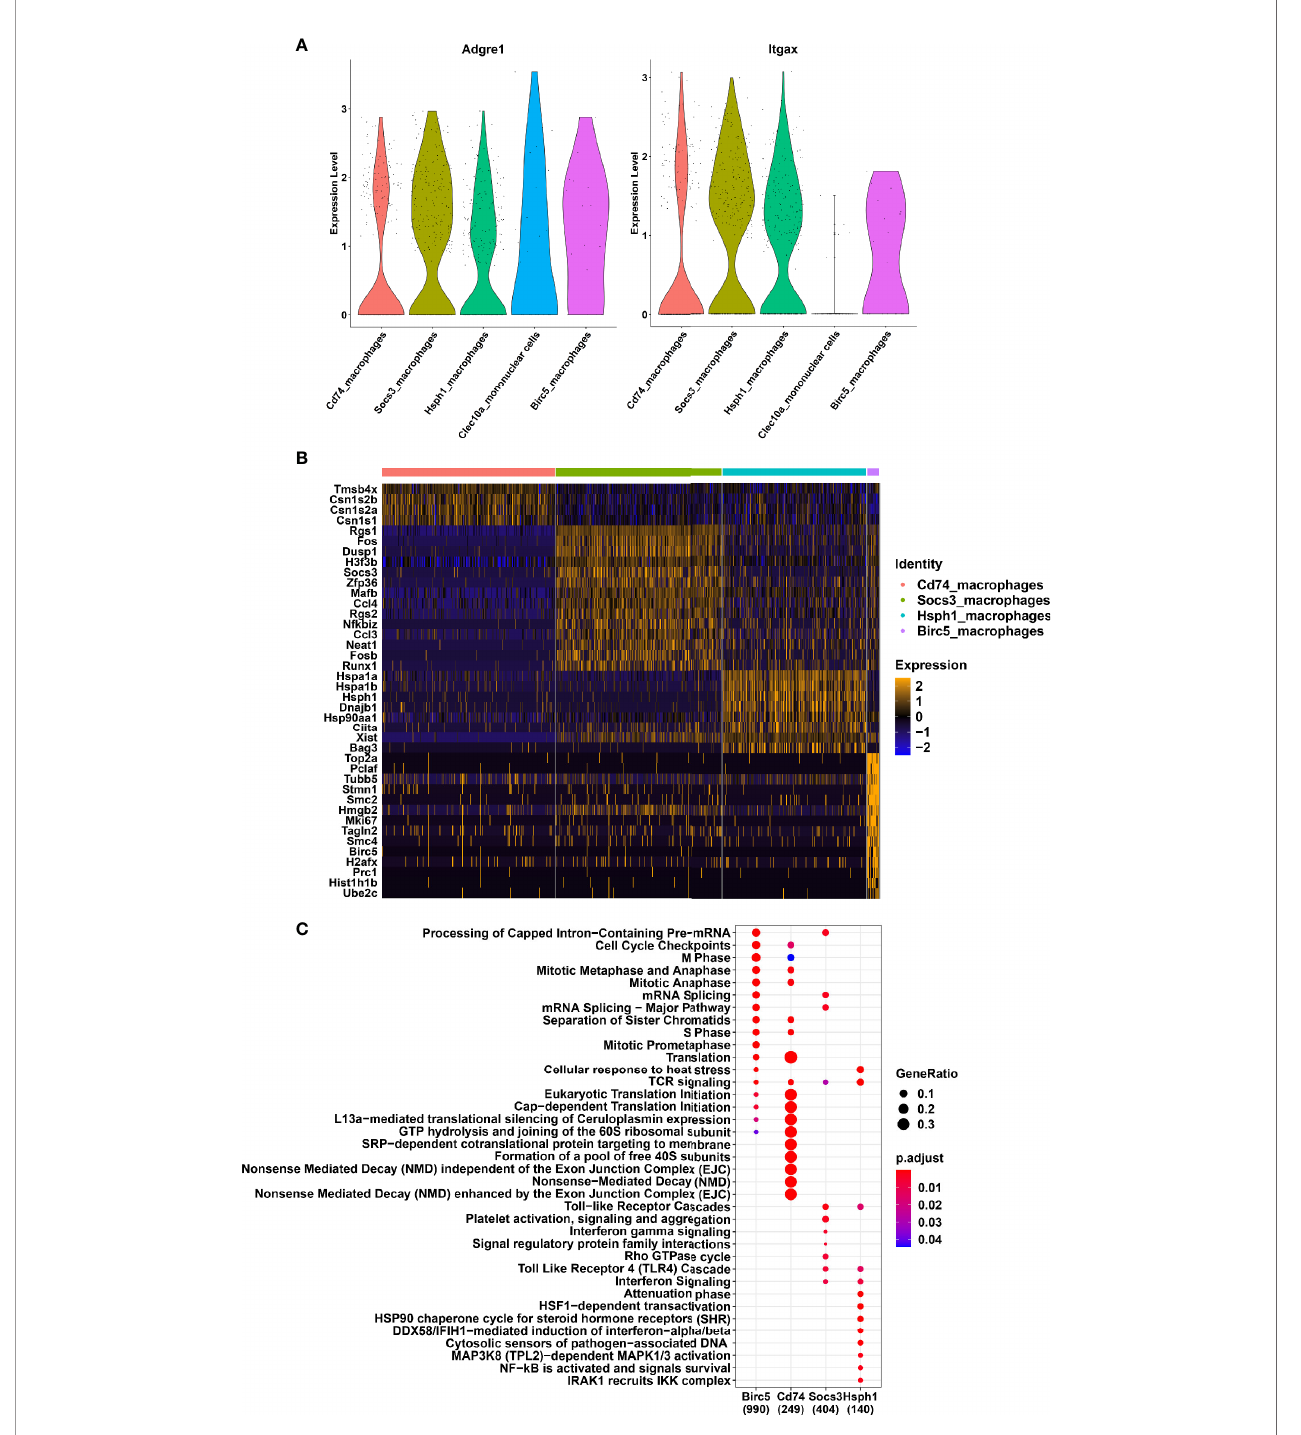
FIGURE 2 | Different subsets of macrophages in the lactating mammary gland (A) Violin plots showing the expression of Adgre1 and Itgax genes in mononuclear phagocyte system clusters. (B) Heatmap indicating the twenty most differentially expressed genes for each macrophage cluster. (C) Reactome pathways enriched in each macrophage cell cluster. The colors of the dots correspond the adjusted p-value. The size of each dot corresponds to the